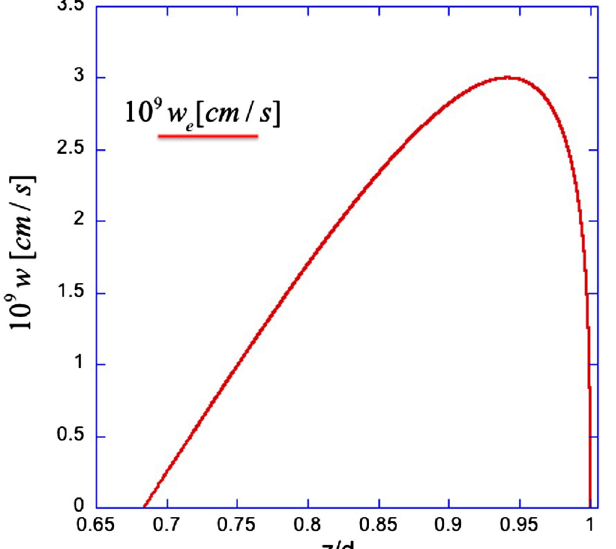
FIG. 3. Electron velocity in units of 10 9 cm = s in the electron current carrying layer for EX in the HE regime of Sec. II B 3, corresponding to Δ I ¼ 0 . 4 MA. See the text for the meaning of the symbols.